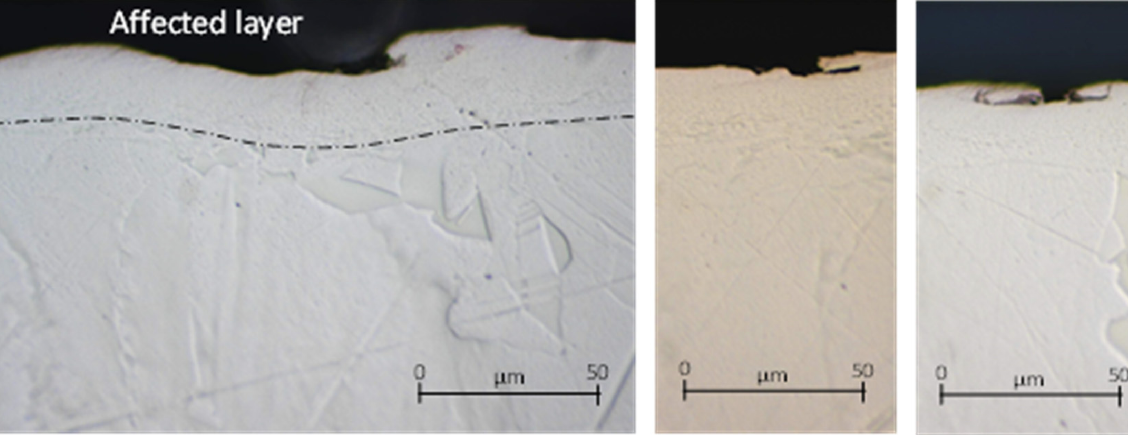
Figure 9. Micrographs of the part surface after a pin-on-disk test under dry condition: 1000-m test.